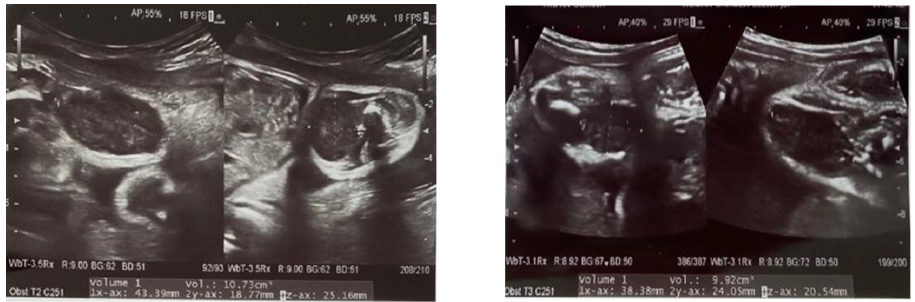
Figure 1. Prenatal ultrasound images at 30 weeks of gestation, showing an oval mass, hypoechoic with calcification on the thigh, with no evidence of bone involvement. The initial X-ray and ultrasound (US) showed a pre-femoral soft tissue mass that measured approximately 30/13 mm, with nonhomogeneous structure, hypoechoic areas, calcifications, and weak Doppler signal, being located anteriorly to the vascular elements of the thigh (Figure 2A). Abdominal ultrasound was normal.